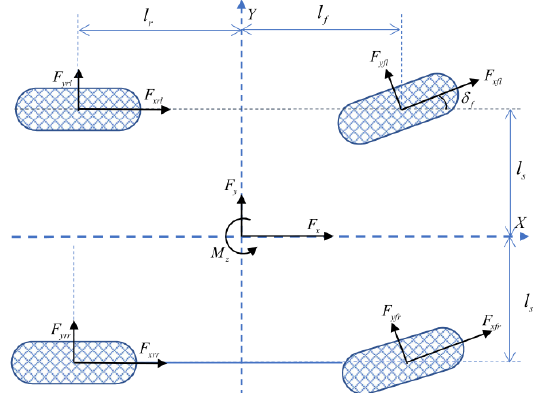
Figure 1. Vehicle dynamics model of